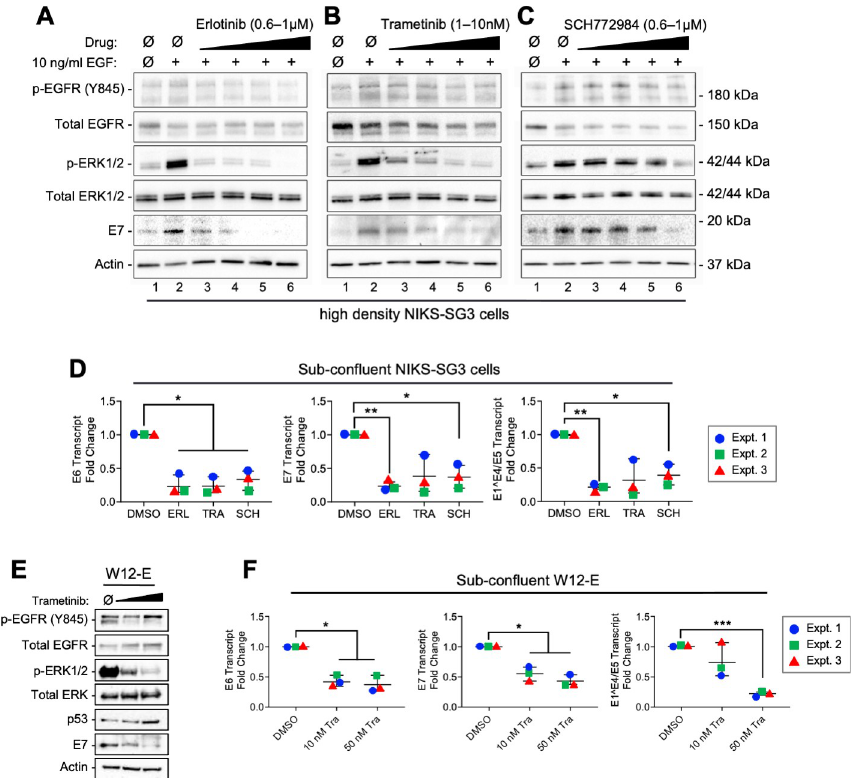
Fig 5. HPV oncogene expression is dependent upon EGFR/MEK/ERK activity in monolayer cell cultures. (A-C) Contact inhibited SG3 cells were grown in the presence of increasing concentrations of erlotinib, trametinib or SCH772984 for 8h prior to EGF stimulation. Protein lysates were collected 14h after EGF stimulation and subject to SDS-PAGE and IB. (D) Cells seeded at low density (2.3 x10 4 cells/cm) were treated with 1 μ M erlotinib, 10nM trametinib, or 1 μ M SCH772984 for 24 hours. Total RNAs extracted from replicate cultures were subjected to RT-qPCR for HPV transcripts and levels were normalized to ribosomal protein 18s mRNA levels. Vehicle treated (DMSO) was set to one in each experiment and the data were analyzed by 1-way ANOVA and Dunnett’s T3 multiple comparison test ( � p < 0.05 or �� p < 0.01). (E-F) W12-E cells were seeded at low density (3.12 x10 4 cells/cm) treated with 10 nM or 50 nM trametinib for 24 hours. (E) Protein (50 μ g) was subject to SDS-PAGE and IB. (F). Total RNAs extracted from replicate cultures were subjected to RT-qPCR for HPV transcript and normalized to ribosomal protein 18s mRNA levels. Vehicle treated (DMSO) was set to one in each experiment and the data was analyzed by 1-way ANOVA with Dunnett’s T3 multiple comparison post hoc test ( � p < 0.05, �� p < 0.01, ��� p <